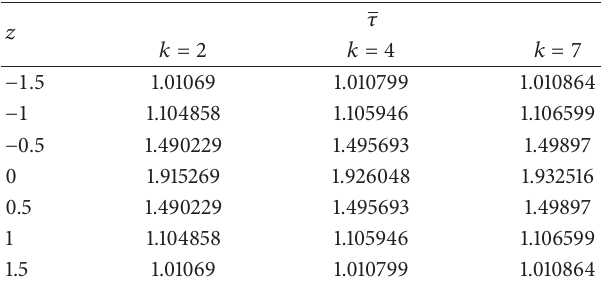
Figure 4: Variations of skin friction 𝜏 1 with axial distance for different percentages of stenosis 𝐿 0 /𝐿 and yield stress 𝜏 𝑐 .